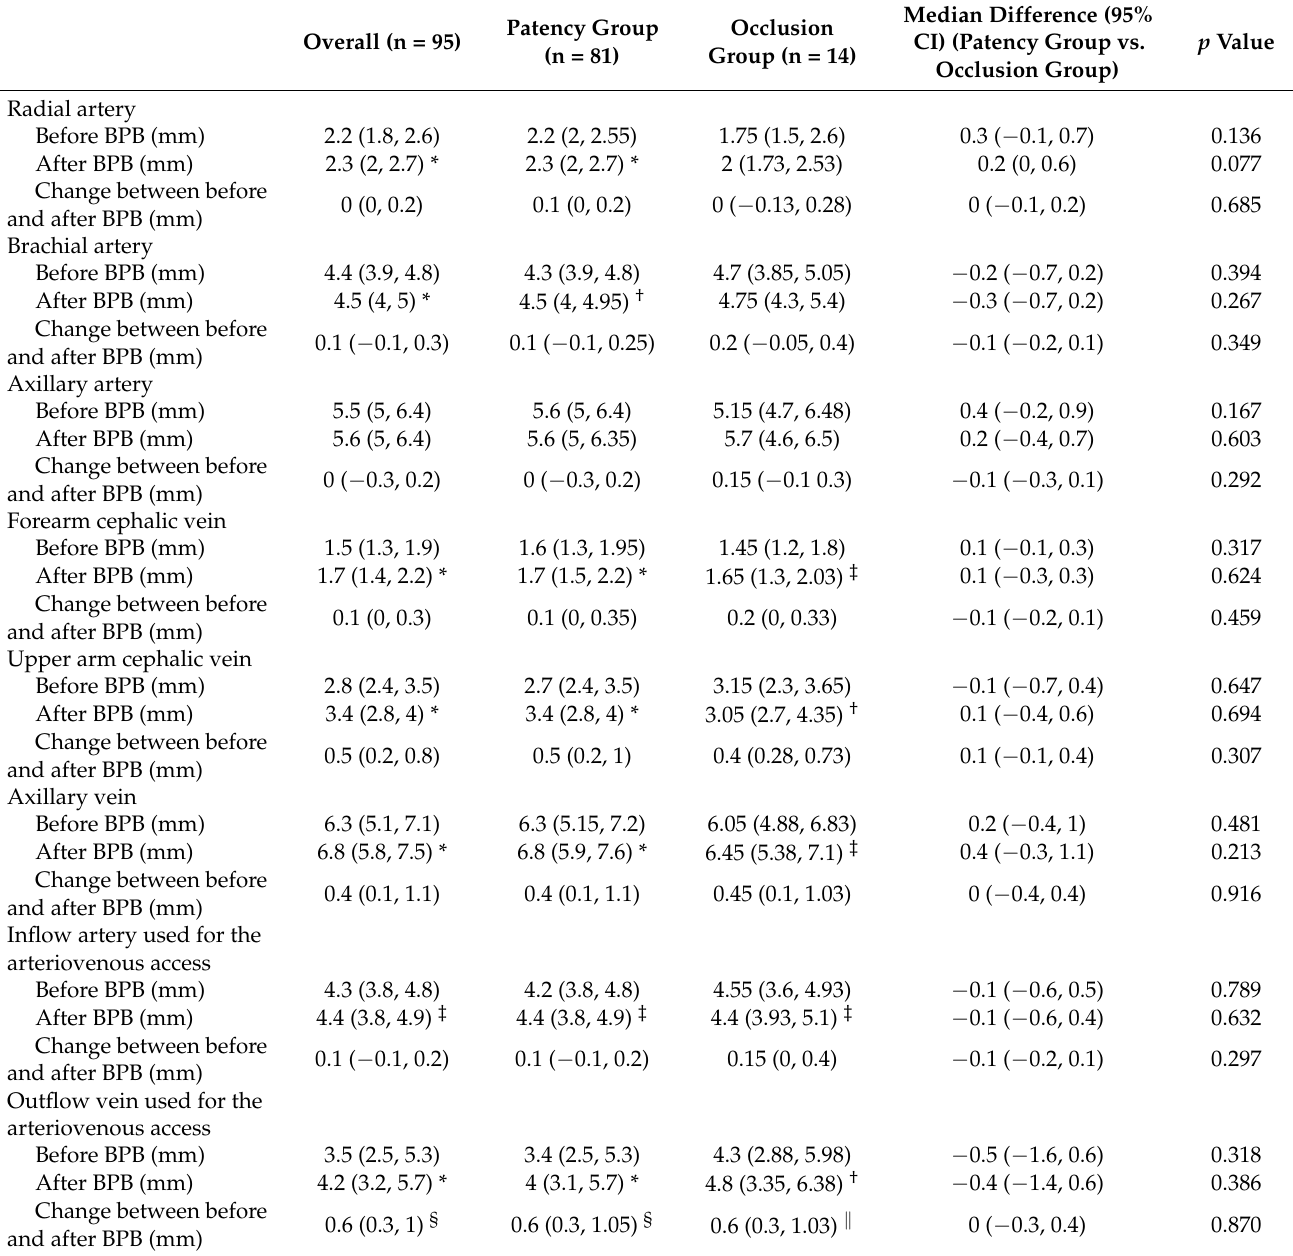
Table 2. Vessel diameters measured before and after brachial plexus